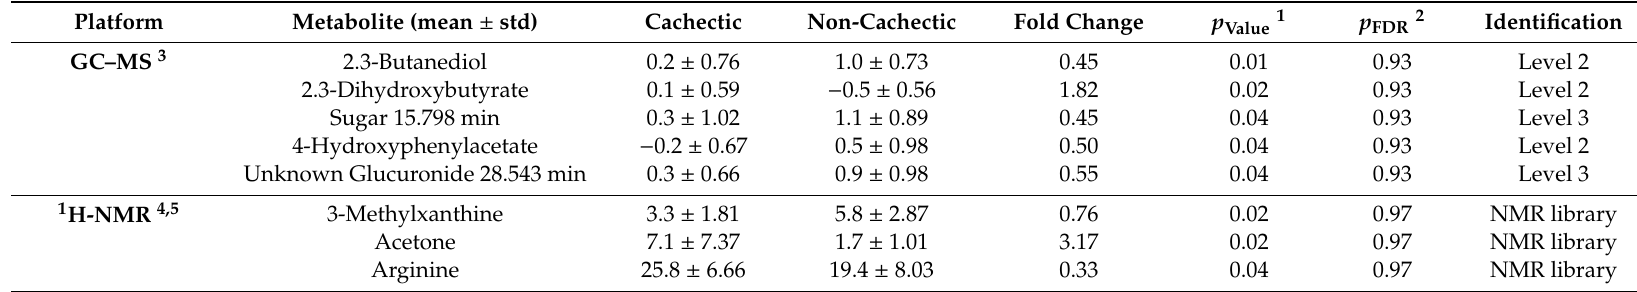
Table 4. Comparison of mean level of metabolites in cachectic and non-cachectic patients. Intensities of the raw peak area of a certain ion (GC–MS) were normalized by sum, log-transformed, and auto-scaled and each spectral bin ( 1 H-NMR) was normalized to creatinine ( µ mol / mmol creatinine) and auto-scaled. + Platform Metabolite (mean ± std)